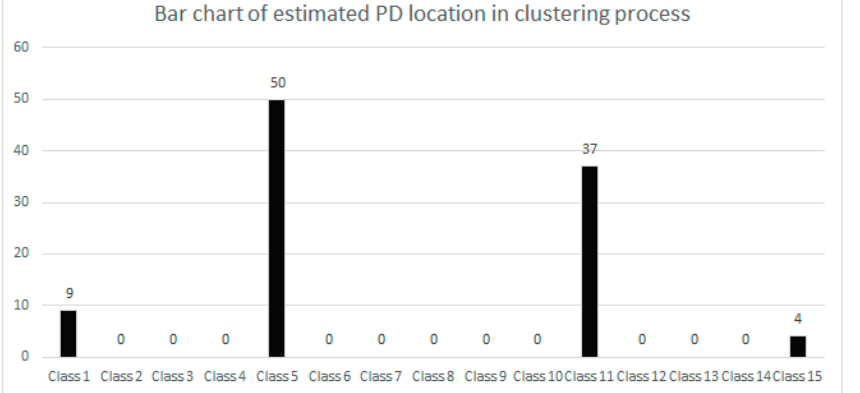
Figure 7 : Bar chart of the estimated PD locations in the clustering process. Figure 7. Bar chart of the estimated PD locations in the clustering process.